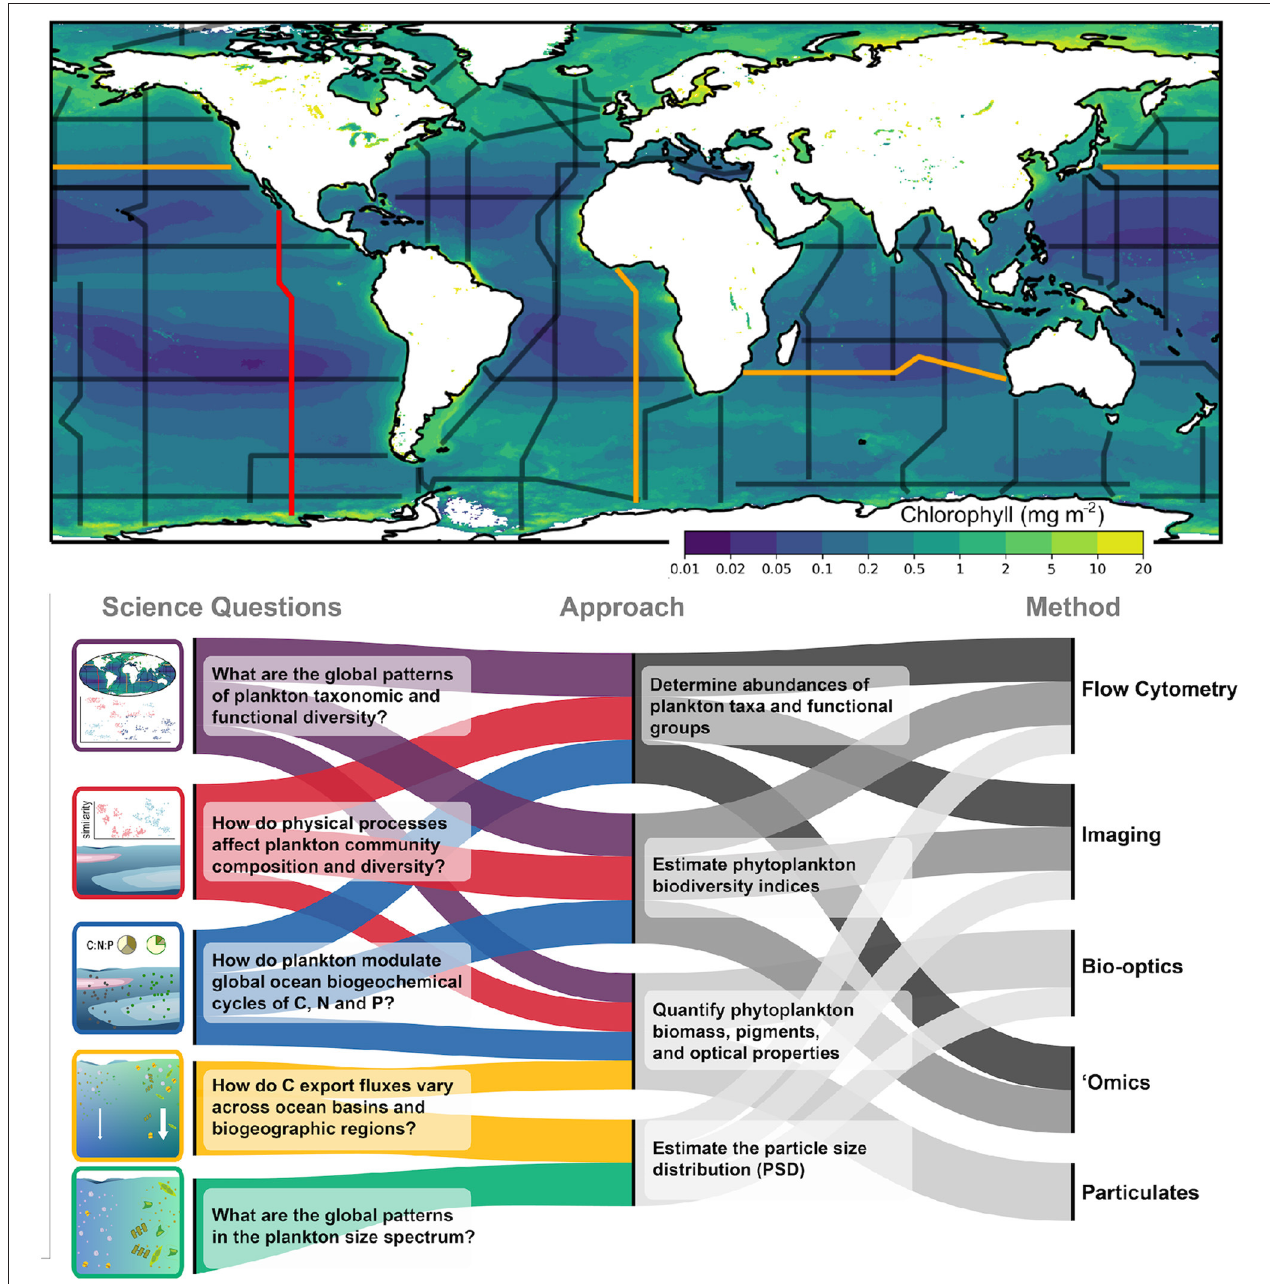
FIGURE 2 | Biological sampling to be incorporated into GO-SHIP. The upper panel shows the GO-SHIP repeat sections overlain on global mean Chlorophyll (mg m − 2 ) obtained from a MODIS mission composite spanning 2002–2021. Section P18 from which the data in Figure 1 was collected is highlighted in red. Highlighted in orange are sections I05, P02, and A13.5, which will be the first sections fully sampled as part of the Bio-GO-SHIP program in 2022–2023. The lower panel summarizes the key science questions that Bio-GO-SHIP addresses, the observational approaches and the range of different measurement types that will be used as part of the Bio-GO-SHIP